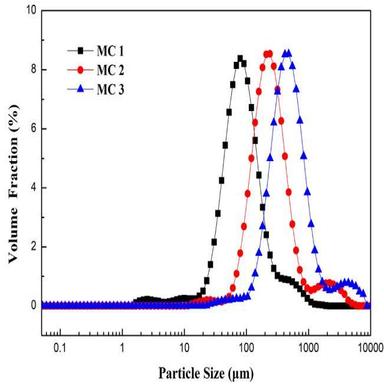
Particle size distributions of different microcapsules.